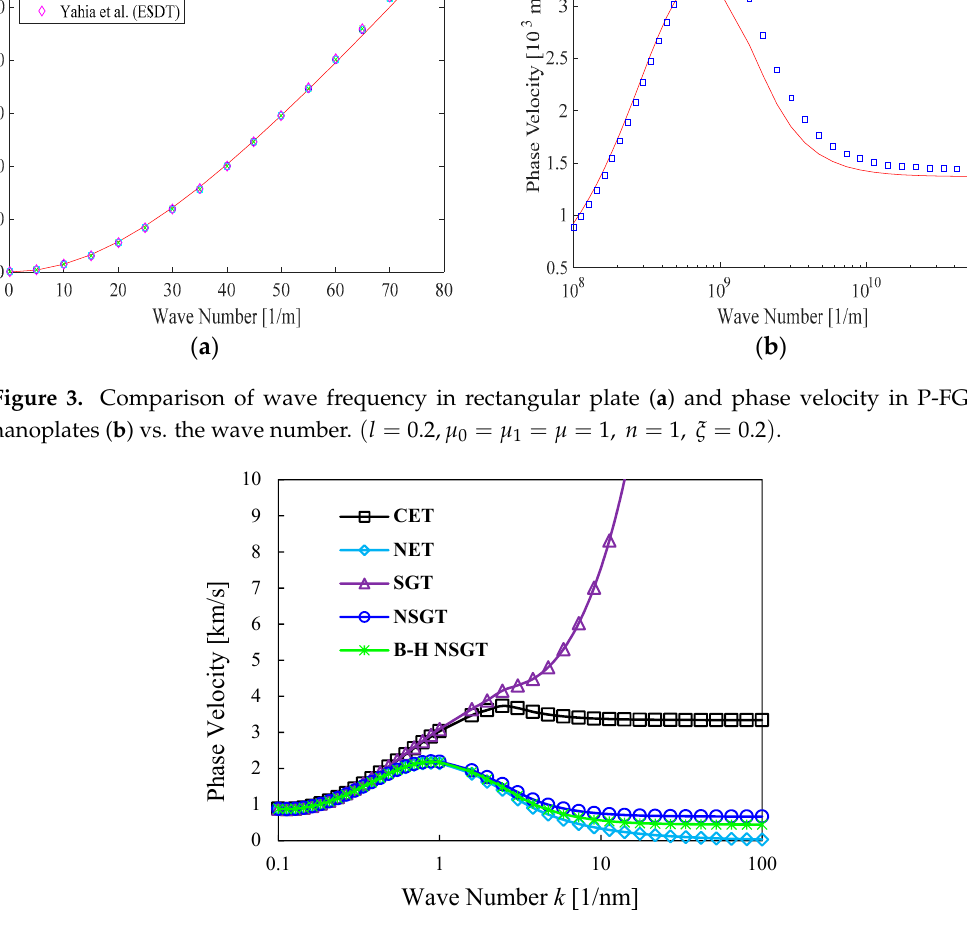
Figure 4. Phase velocity of the P-FGM doubly-curved nanoshell vs. the wave number for different elasticity theories, µ 0 = µ 1 = µ = 0, and l = 0 for Classical Elasticity Theory (CET); µ 0 = µ 1 = µ = 1.0 nm, and l = 0 for non-local elasticity theory (NET); µ 0 = µ 1 = µ = 0 , and l = 0.2 nm for strain gradient theory (SGT); µ 0 = µ 1 = µ = 1.0 nm, and l = 0.2 nm for non-local strain gradient theory (NSGT); µ 0 = 1 nm, µ 1 = 1.5 nm,and l = 0.2 nm for the B-H NSGT. ( R 2 = R 1 = 50 × h , n = 2, ξ =